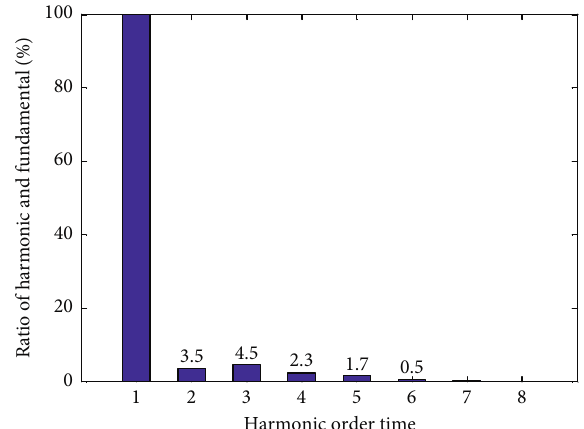
Figure 9: Harmonic component of the induced electromotive